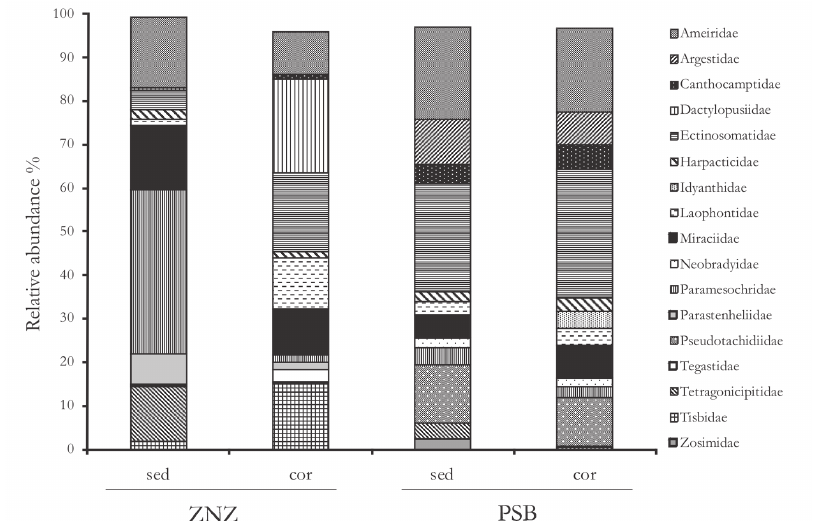
Fig . 2. – Harpacticoid family composition per microhabitat (sed: sediment, cor: coral) in the tropical lagoon on Zanzibar (ZnZ) and the cold- water coral degradation zone at the Porcupine seabight (PsB), based on pooled samples per microhabitat. Families with a relative abundance >2% in at least one microhabitat (in ZnZ or PsB) are given.